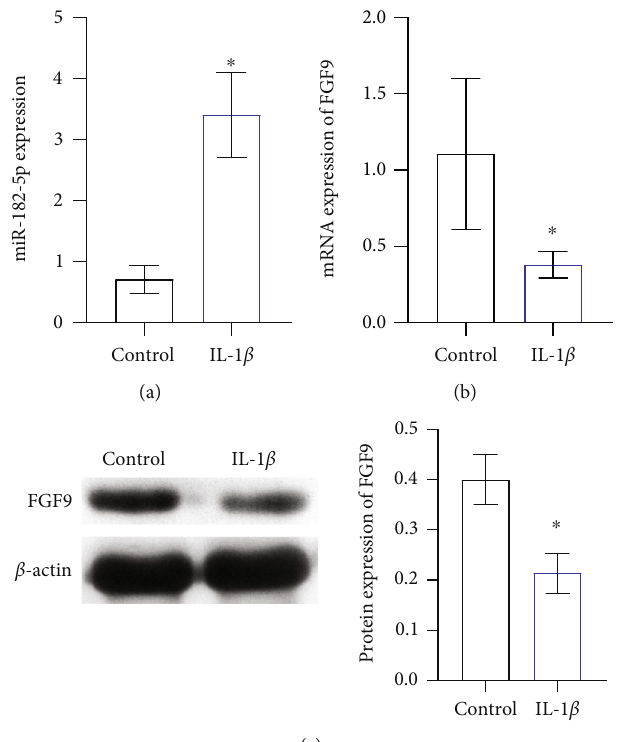
Figure 1: The expression of miR-182-5p and FGF9 in OA chondrocytes was changed. The gene expression of (a) miR-182-5p and (b) FGF9. (c) The protein expression of FGF9. * P < 0 : 05 vs.